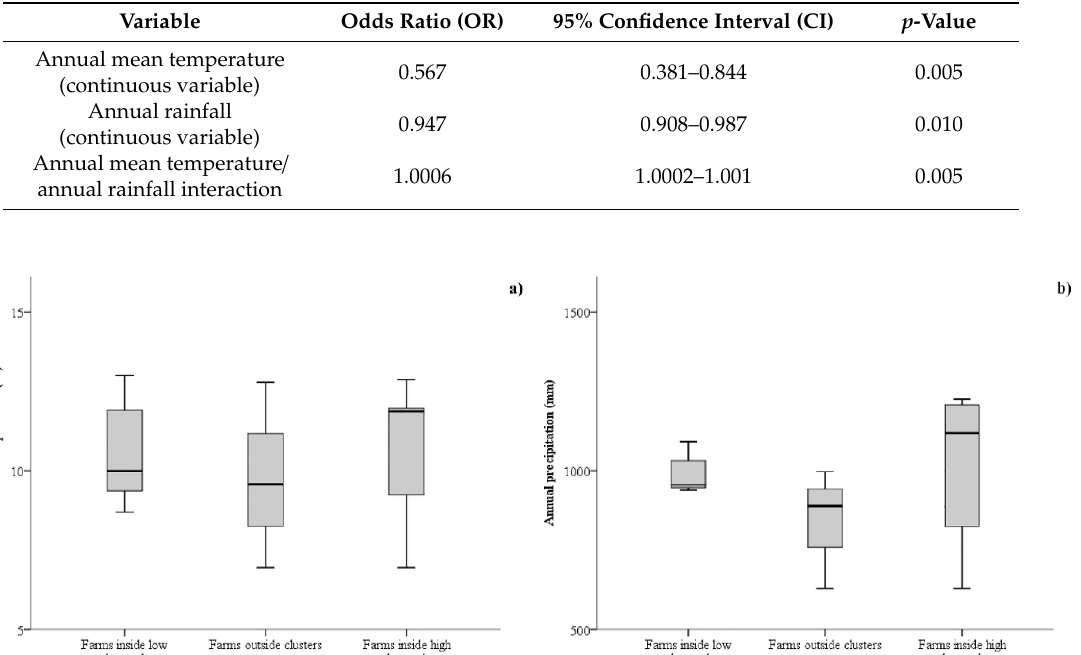
Table 5. Possible risk factors associated with higher Neospora caninum prevalence in goat farms using univariate